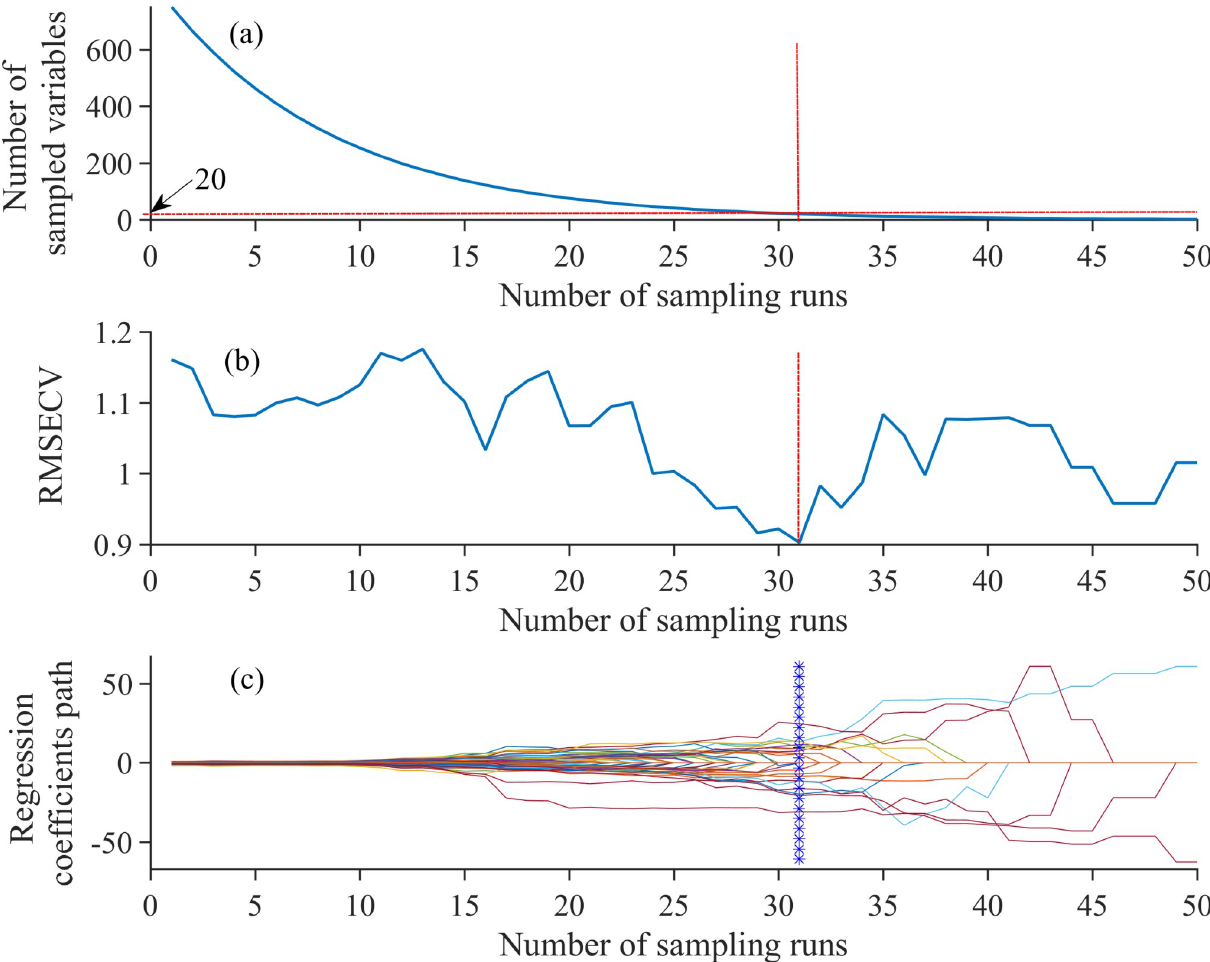
Fig 6. The altering trend of the CARS algorithm with the increasing of sampling runs. (a) The number of sampled variables, (b) the RMSECV values, and (c) the regression coefficients of each